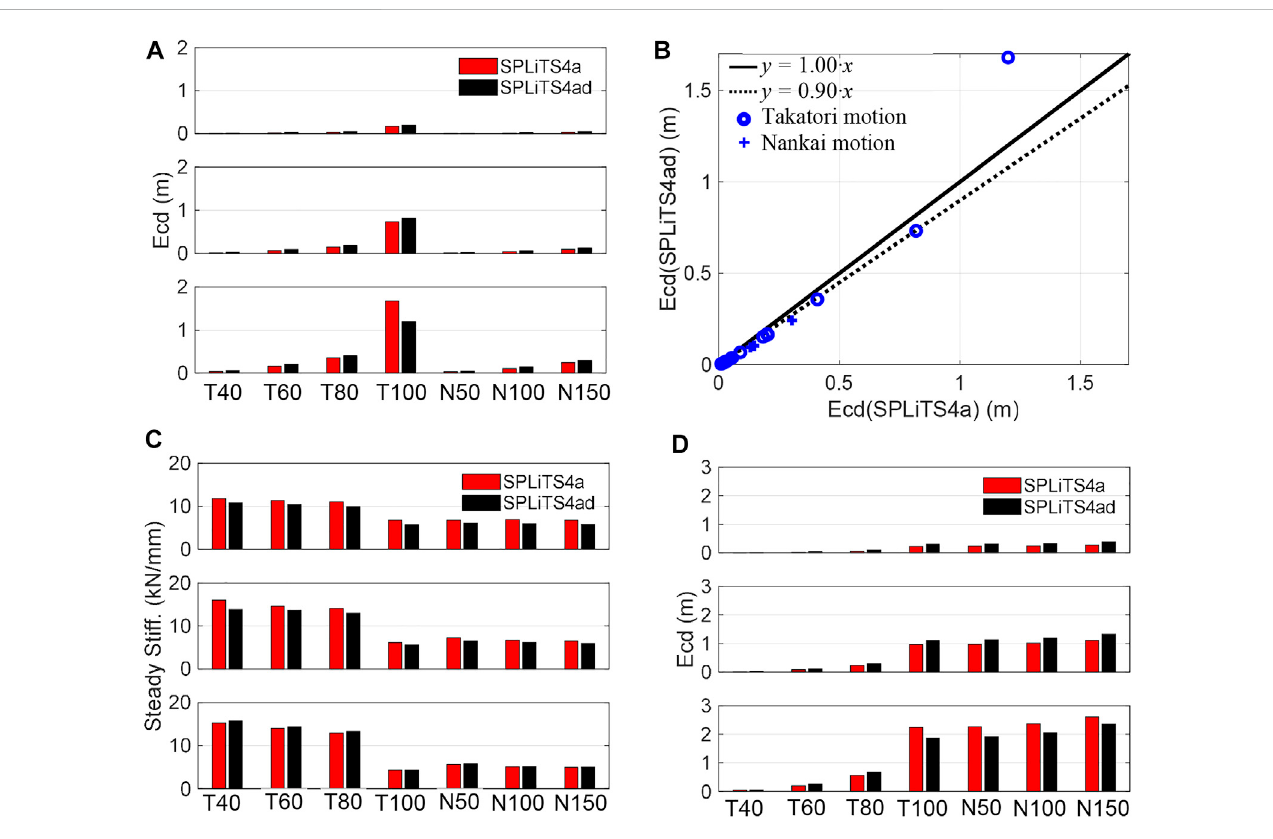
FIGURE 15 Results obtained by SPLiTS4a/ad: (A) maximum structural energy absorption E * cd , (B) comparison of E * cd , (C) steady stiffness, and (D) accumulation of E * cd . N.B.: The top, middle and bottom in each fi gure corresponds to third, second, and fi rst storeys,